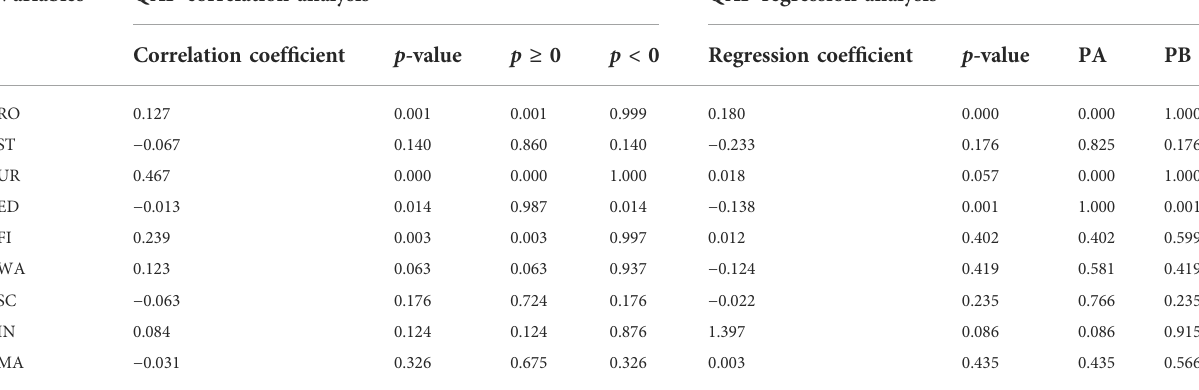
TABLE 8 The analysis of driving factors of spatial association network of